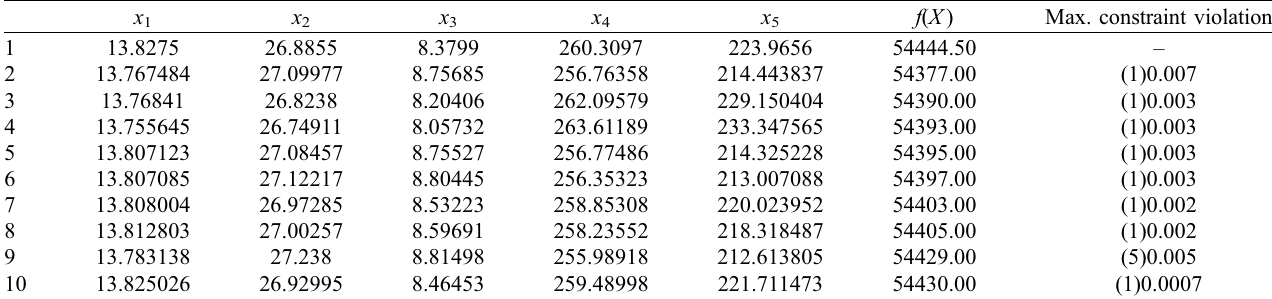
Table 8. Top ten optimum solutions obtained for example 2 using